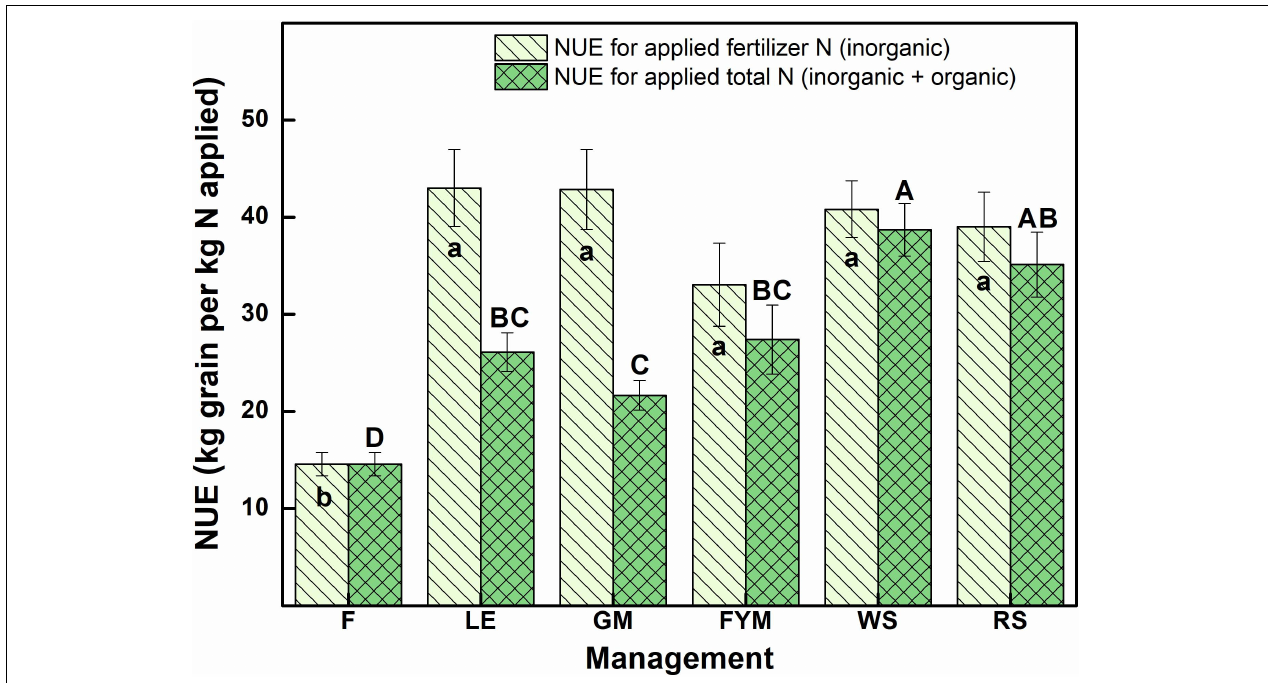
FIGURE 7 | Nitrogen use efficiency (NUE) of the wheat crop in response to different management after 10 years of management (averages for 2014–15 and 2015–16). Error bars denote ± 1SD. For respective parameters, treatments with the same digits are not significantly different at p ≤ 0.05, using Tukey’s HSD. Small letters represent differences for applied fertilizer N (inorganic), and capital letters represent differences for total applied N (inorganic + organic), small italic letters represent differences for NH 4 + -N and capital letters represent differences for total plant-available N. Treatments are described in Figure 2